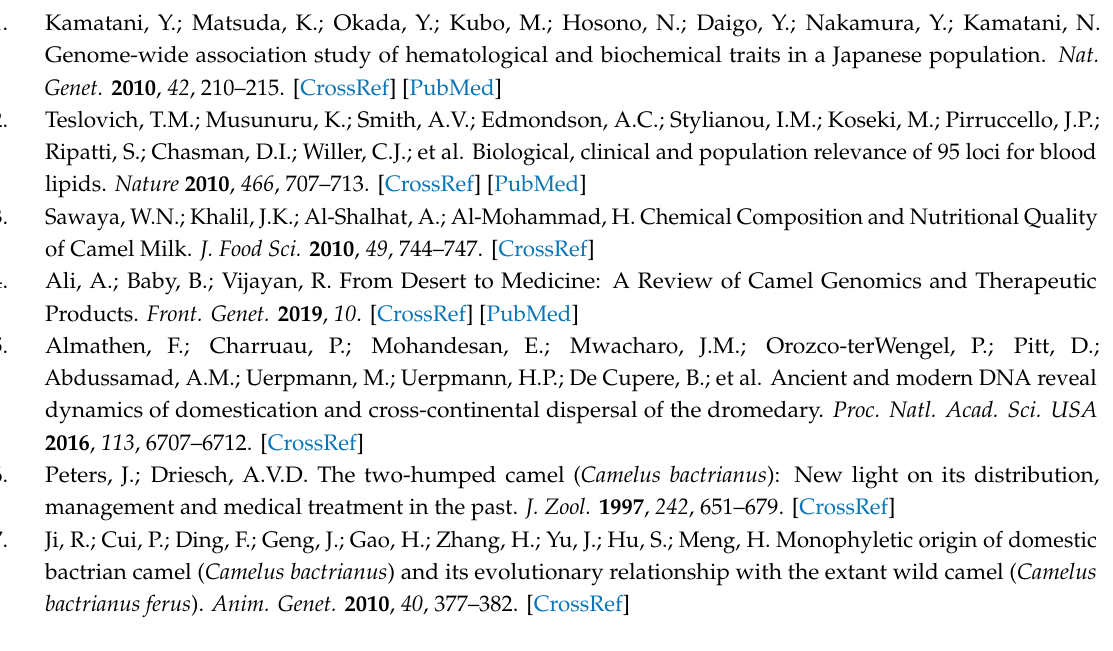
Table S1: Sample information for 366 Bactrian camels. Table S2: Sequencing data statistics and quality assessment. Table S3: Sequencing depth and coverage statistics. Table S4: Genome-wide association study (GWAS)-related gene function annotation. Table S5: Candidate genes associated with blood traits. White blood cell, WBC. Red blood cell, RBC. Hemoglobin, HGB. Average red blood cell volume, MCV. Hematocrit, HCT. Mean hemoglobin content, MCH. Mean hemoglobin concentration, MCHC. Red blood cell distribution width SD, RDW_SD. Red blood cell distribution width cell volume (CV), RDW_CV. Average platelet volume, MPV. Total platelet volume, PCT. Platelet distribution width, PDW. Glutamyl transpeptidase, GGT. Cholesterol, CHO. Supplementary Figure S1: Manhattan plots and quantile–quantile (Q–Q) plots for the total number of red blood cells (RBCs). Supplementary Figure S2: Manhattan plots and quantile–quantile (Q–Q) plots for hemoglobin (HGB). Supplementary Figure S3: Manhattan plots and quantile–quantile (Q–Q) plots for the average red blood cell volume (MCV). Supplementary Figure S4: Manhattan plots and quantile–quantile (Q–Q) plots for the hematocrit (HCT) value. Supplementary Figure S5: Manhattanplotsandquantile–quantile(Q–Q)plotsforthemeanhemoglobincontent(MCH).SupplementaryFigure S6: Manhattan plots and quantile–quantile (Q–Q) plots for the red blood cell distribution width SD (RDW_SD). Supplementary Figure S7: Manhattan plots and quantile–quantile (Q–Q) plots for the red blood cell distribution width cell volume (CV) (RDW_CV). Supplementary Figure S8: Manhattan plots and quantile–quantile (Q–Q) plots for the average platelet volume (MPV). Supplementary Figure S9: Manhattan plots and quantile–quantile (Q–Q) plots for the total platelet volume (PCT). Supplementary Figure S10: Manhattan plots and quantile–quantile (Q–Q) plots for the platelet distribution width (PDW). Supplementary Figure S11: Manhattan plots and quantile–quantile (Q–Q) plots for glutamyl transpeptidase (GGT). Supplementary Figure S12: Manhattan plots and quantile–quantile (Q–Q) plots for cholesterol